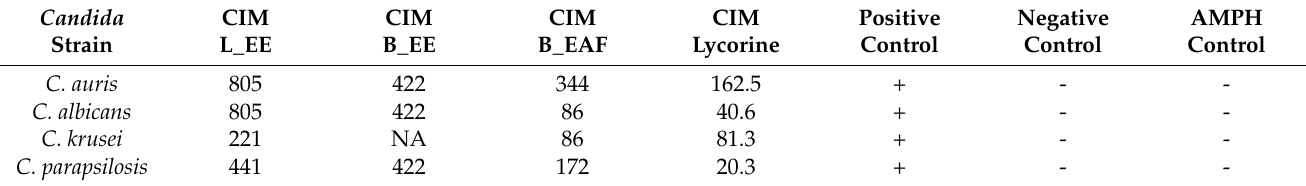
Table 1. MIC values of the extracts and lycorine against Candida spp. strains (results in μ g / mL).